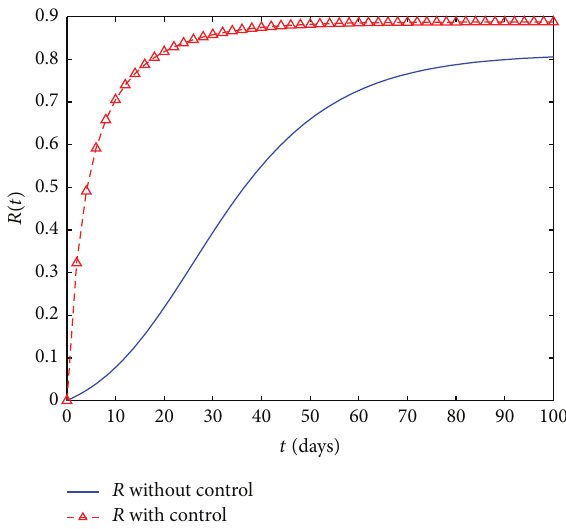
Figure 11: Recovered individuals 𝑅(𝑡) in case of optimal control versus without